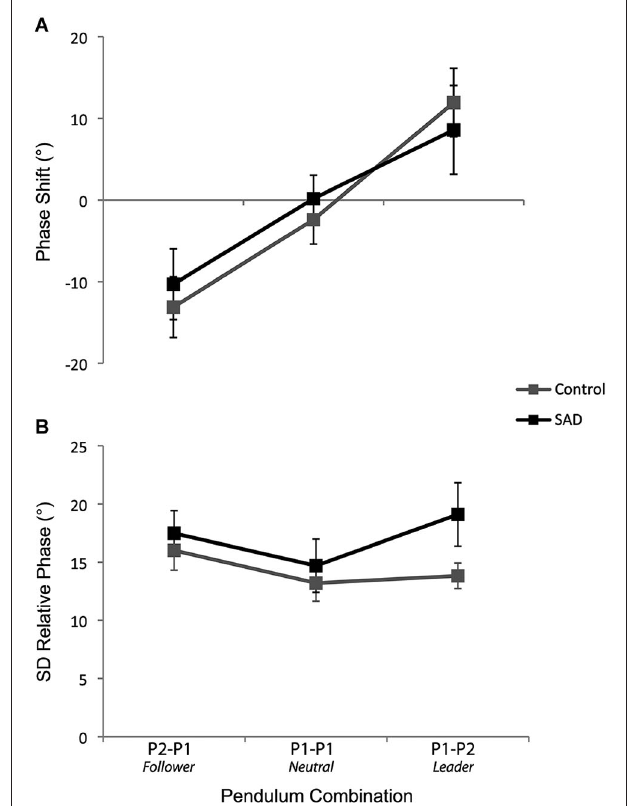
FIGURE 2 | The phase shift from the intended coordination (A) and the standard deviation of relative phase (B) for the control and SAD groups as a function of the pendulum combination. The error bars represent the standard error of the